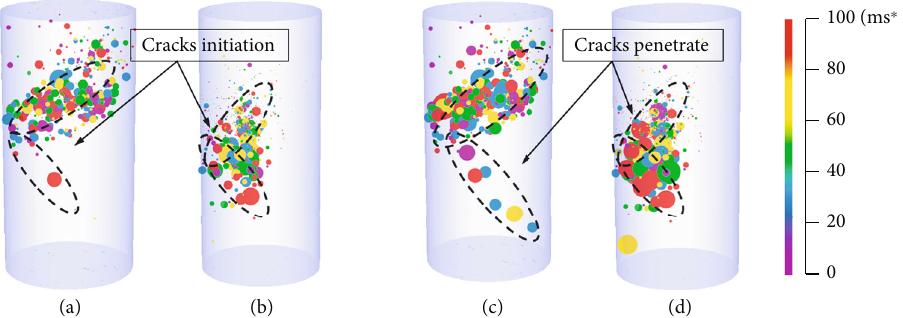
Figure 4: The fracture characteristic of red sandstone by AE events. (a) The result of specimen R1 when D = 0 : 5 . (b) The result of specimen R6 when D = 0 : 5 . (c) The result of specimen R1 when D = 1 . (d) The result of specimen R6 when D = 1